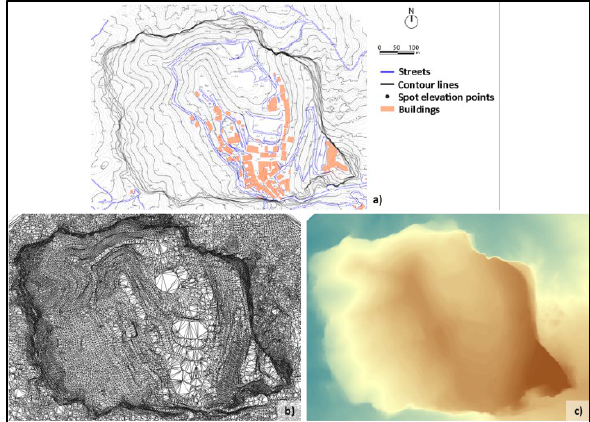
Figure 4. TLS surveys: a) scan-positions of the 2013 (red dots) and of 2014 (blue dots); b) aligned point clouds after 2013 surveys activities (about 900.000.000 points); c) south side true coloured point cloud.